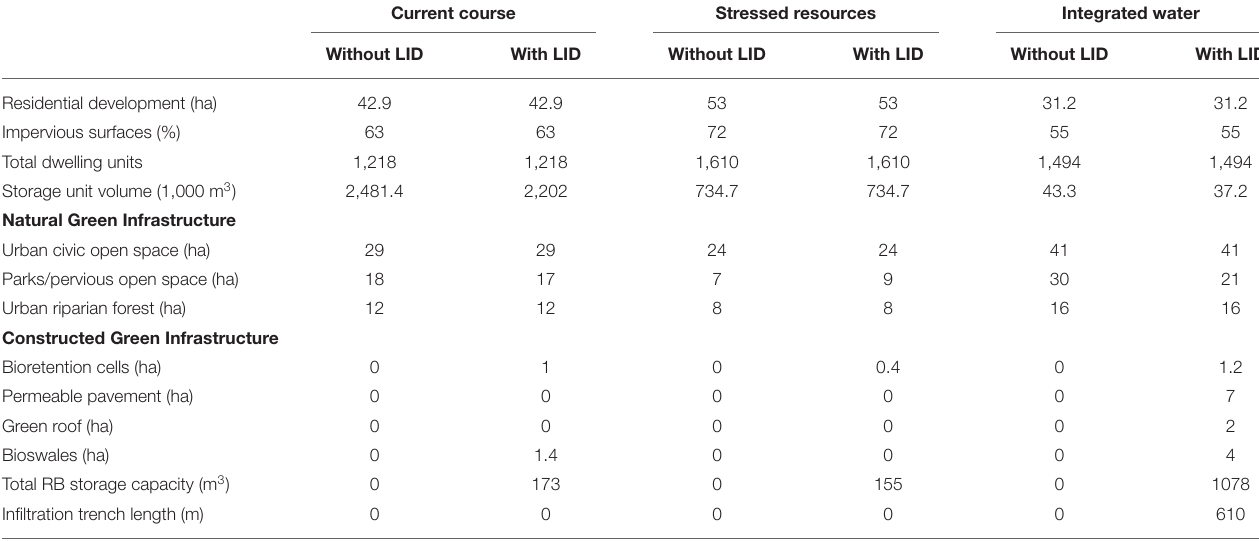
TABLE 1 | Descriptive features of